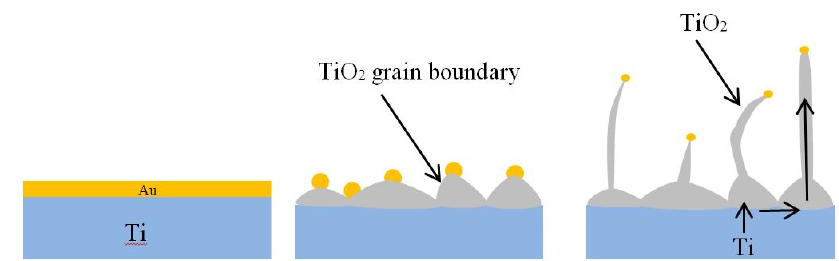
Figure 7. E ff ect of the Au catalyst on the growth of TiO 2 Figure 7. Effect of the Au catalyst on the growth of TiO 2 NWs. Figure 7. Effect of the Au catalyst on the growth of TiO 2 NWs.